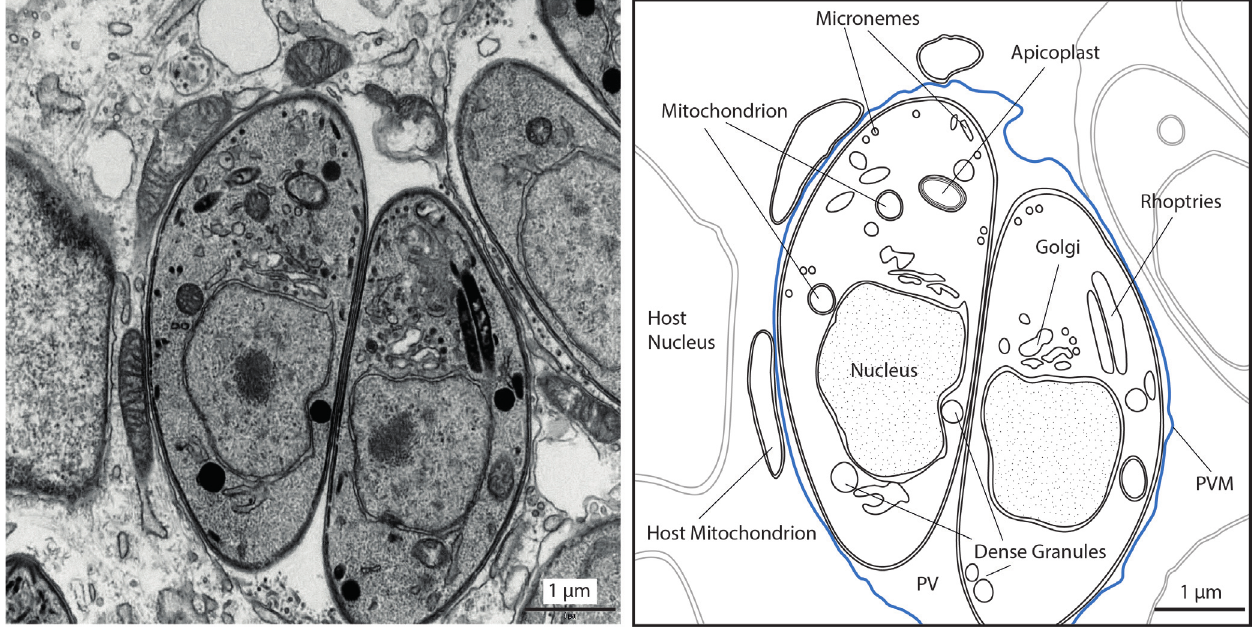
Figure 1. Morphology of intracellular Toxoplasma gondii tachyzoites. Transmission electron micrograph of the intracellular Toxoplasma gondii tachyzoite stage as one example of Apicomplexa. Shown are parasites inside an infected fibroblast host cell, residing within a parasitophorous vacuole (PV), which is surrounded by a membrane (parasitophorous vacuolar membrane, PVM, in blue) (left). On the right, some host and parasite organelles are outlined. The apicoplast is a plastid-derived organelle harboring some essential metabolic pathways. Micronemes are specialized secretory organelles at the apical end that store proteins important for gliding motility and host cell invasion 130 . The role of dense granules and rhoptries are detailed in the text. This basic organellar setup is shared with Plasmodium